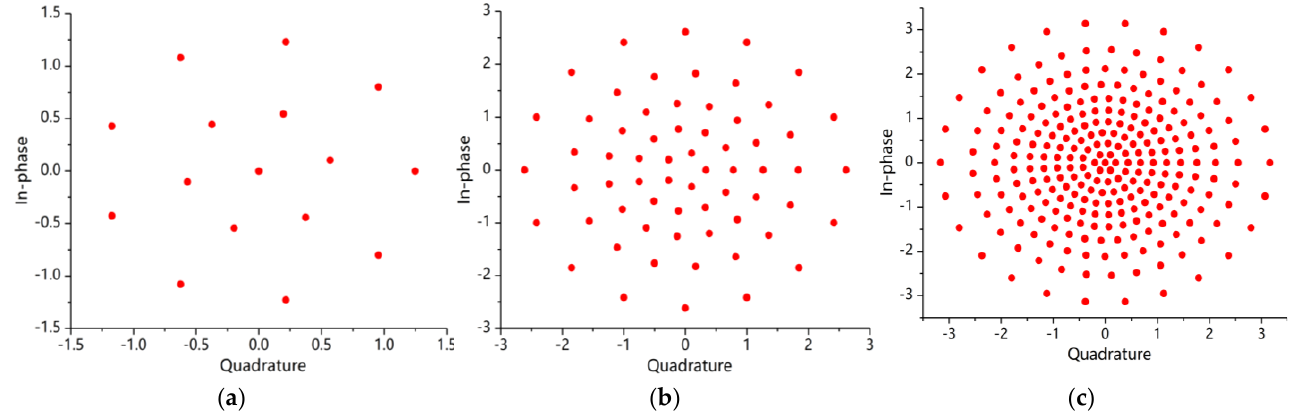
Figure 1. Different orders of constellation based on IPM ( a ) M = 16; ( b ) M = 64; (c) M = 256.